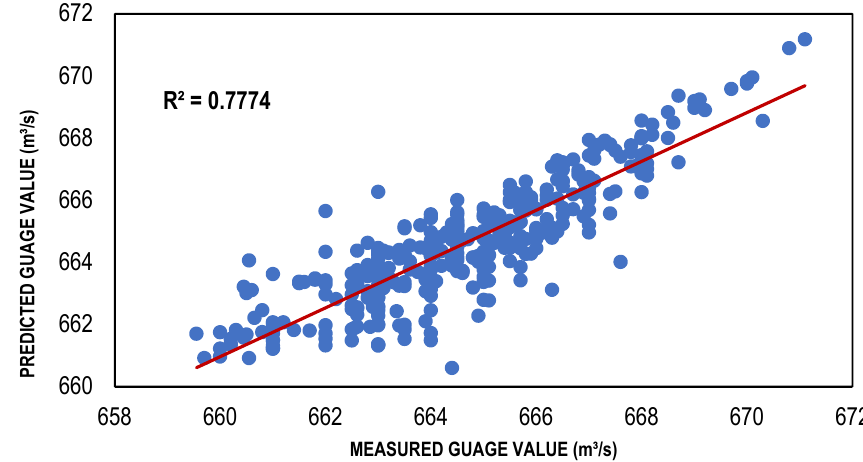
Figure 8. Best BFGS-based models (training and testing) .